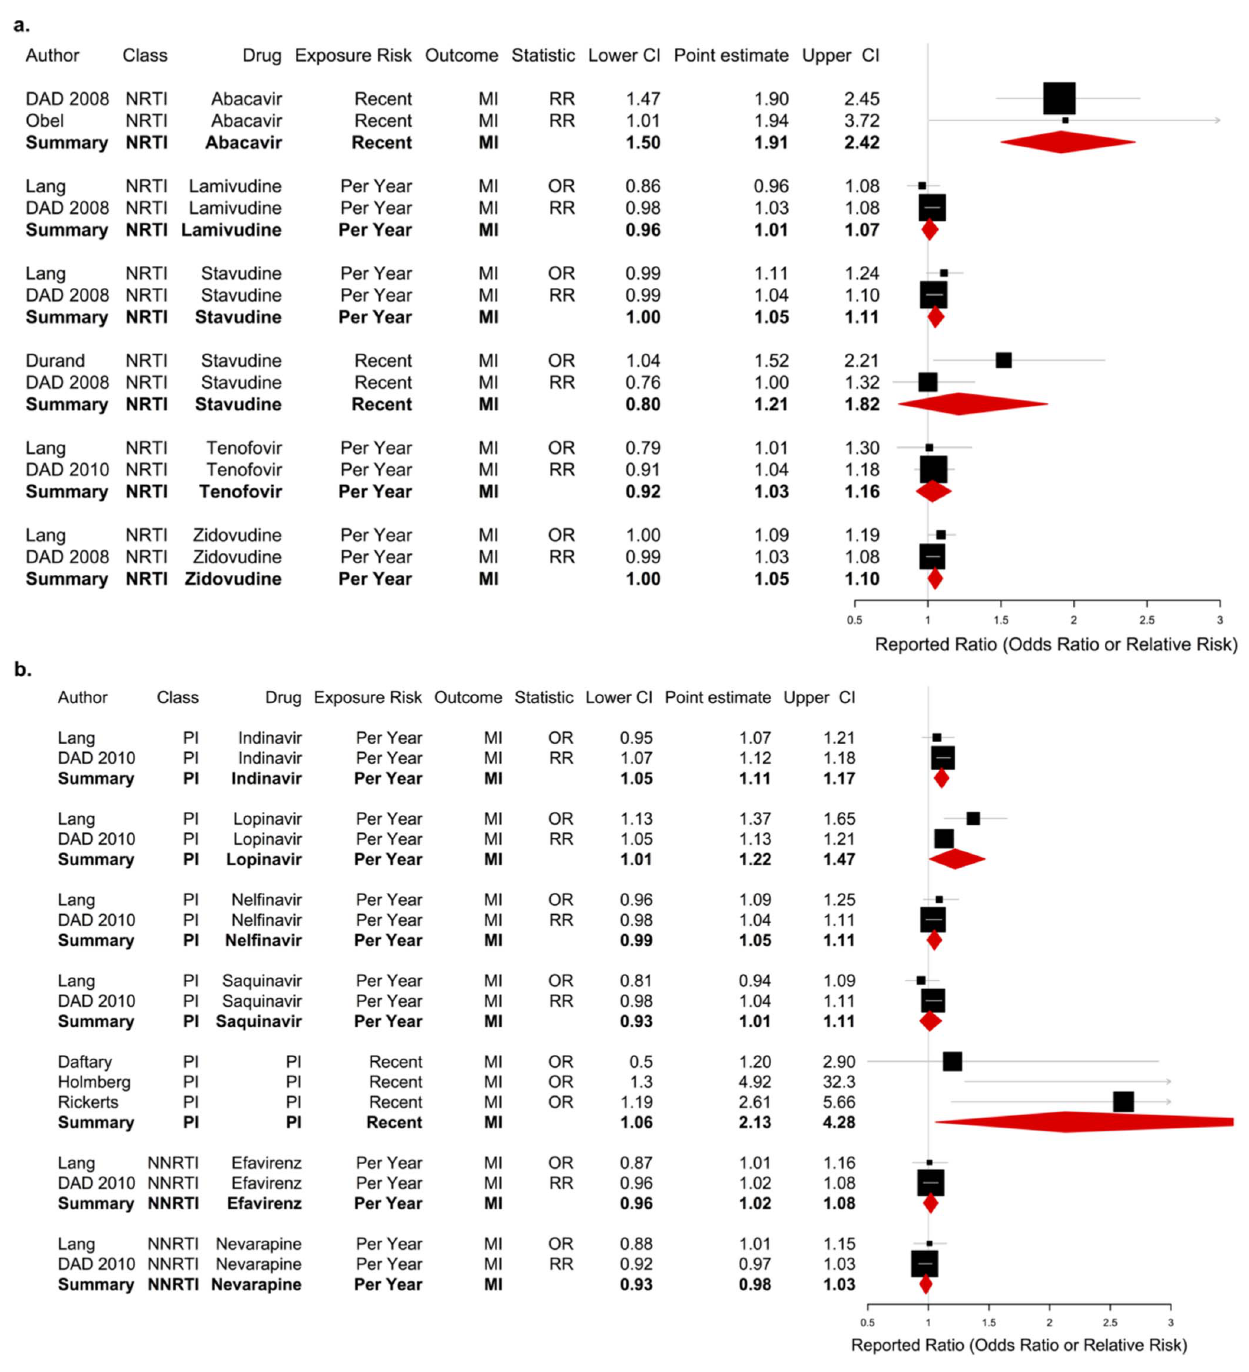
Figure 4. (a, b) Reported risk ratio and 95% confidence interval for exposure groups with sufficient evidence to summarize in meta- analysis. Results of meta-analysis are shown in bottom row of each exposure group, denoted pictorially by the red diamond. Each study is given a weight based on its number of subjects and length of follow-up, denoted pictorially by size of its box in the plot. Note that risk of recent exposure represents the effect of exposure to the agent within the past 6 months relative to non-exposure in the past 6 months, and risk per year represents the effect of one additional year of exposure to the agent.